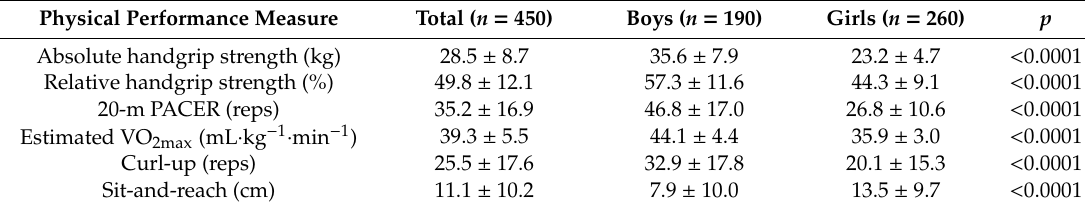
Table 3. Physical performance levels of Korean